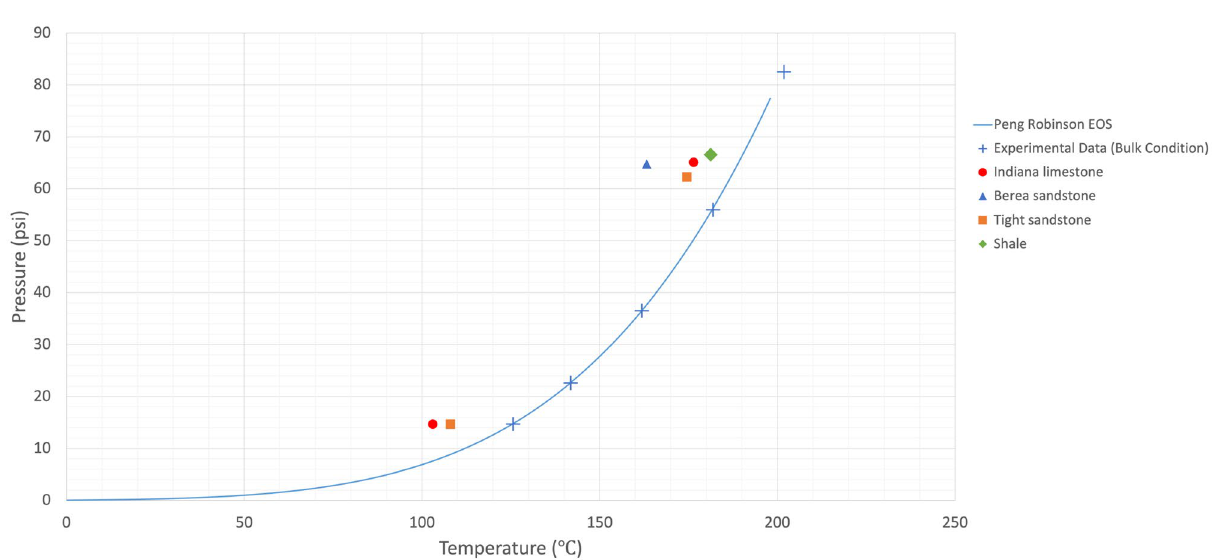
Figure 4. Mean vaporization temperatures of heptane in various rocks and computed phase-change temperatures obtained from the PR-EoS at different pressures. The experimental data were obtained from the phase-change measurement at bulk conditions.